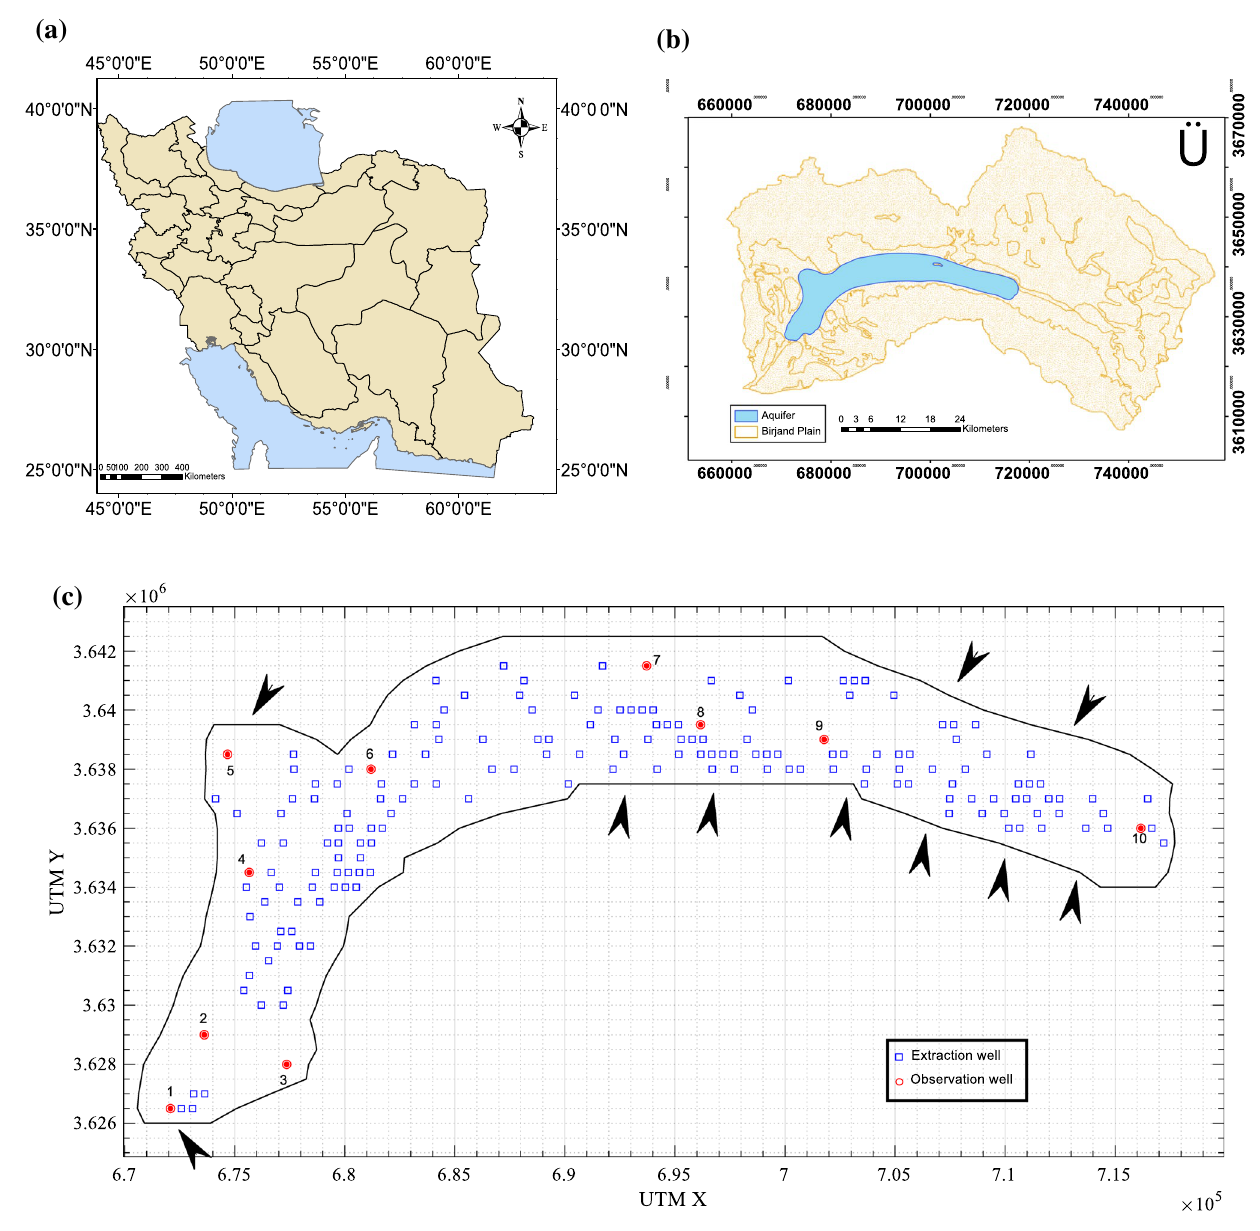
Fig. 1 Location of Birjand unconfined aquifer in Iran (Mohtashami et al.